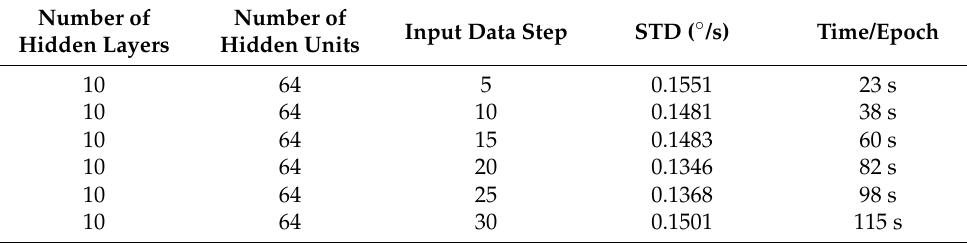
Table 3. Performance with varying values of the input data step.